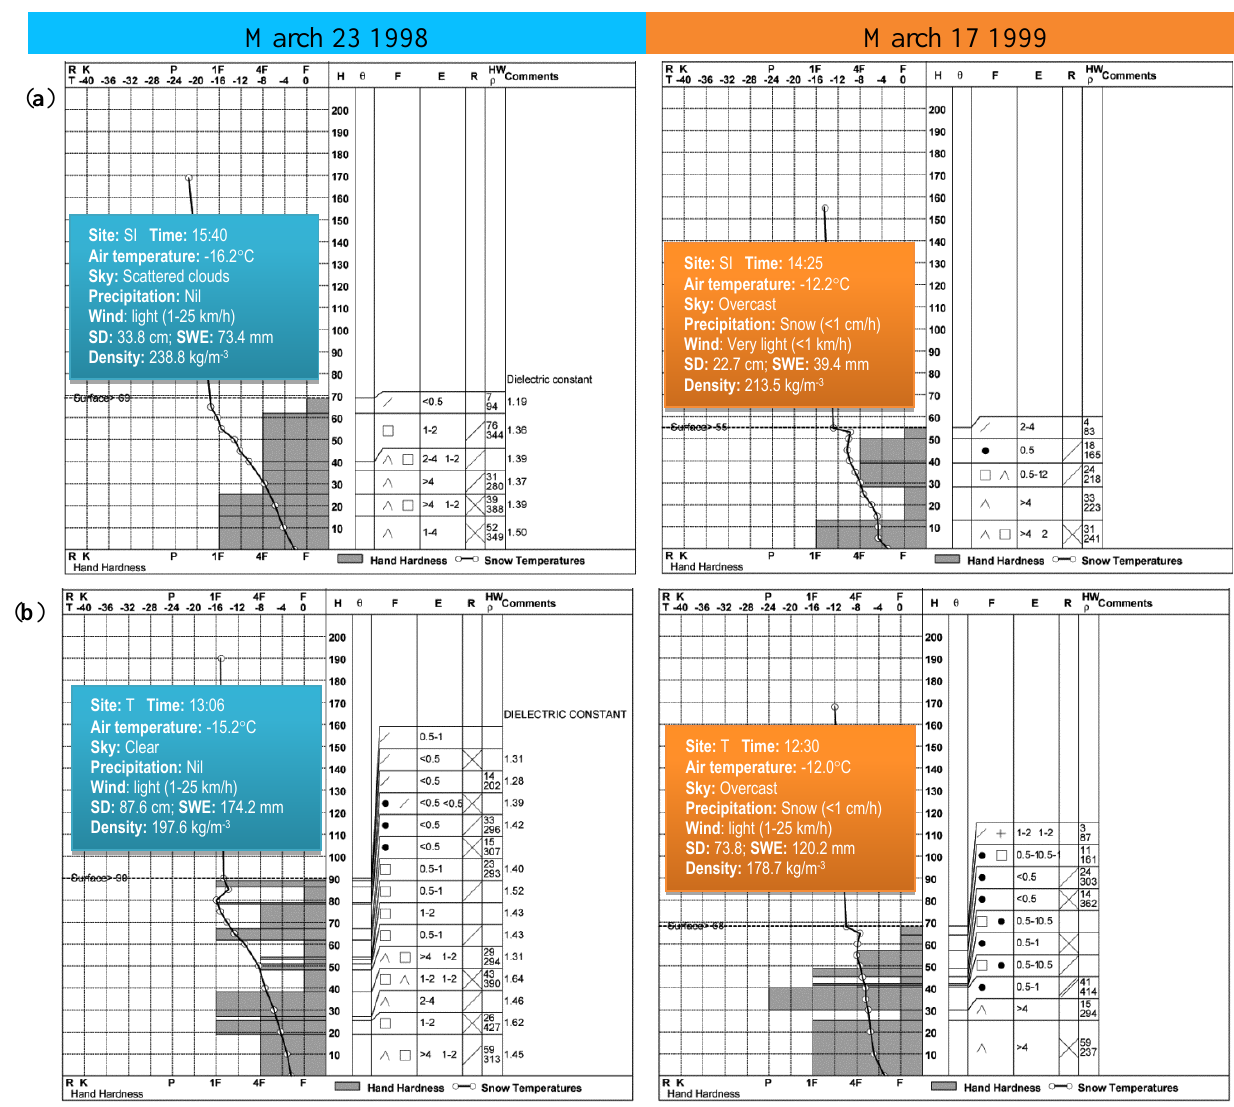
Figure 5. The snow stratigraphic profiles in the ( a ) sedge fen area (SI), ( b ) transition zone (T) and ( c ) open coniferous forest (FI), which are coincident with the RADARSAT-1 overpasses at the time of peak snow accumulation during the winters of 1997/98 and